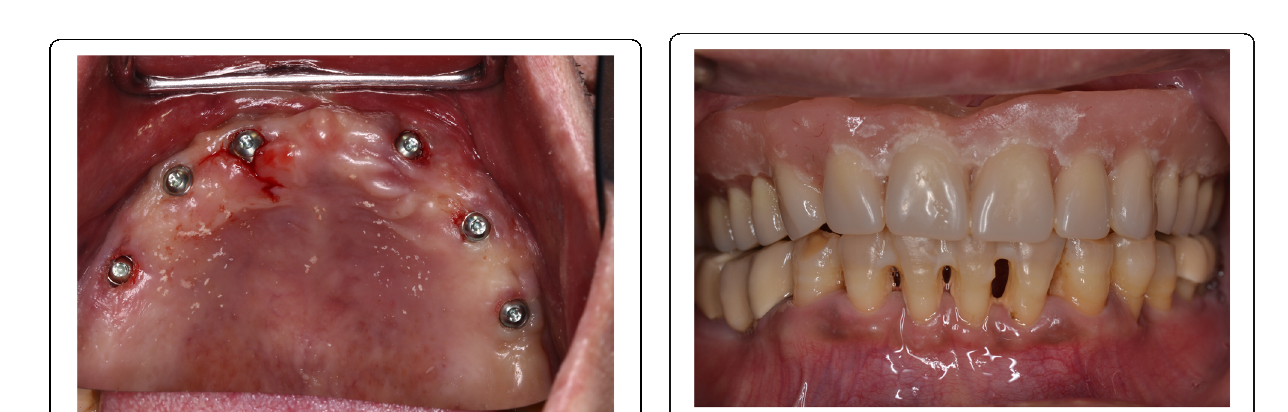
Fig. 5 Flapless placement of six maxillary implants Fig. 6 Denture relined with